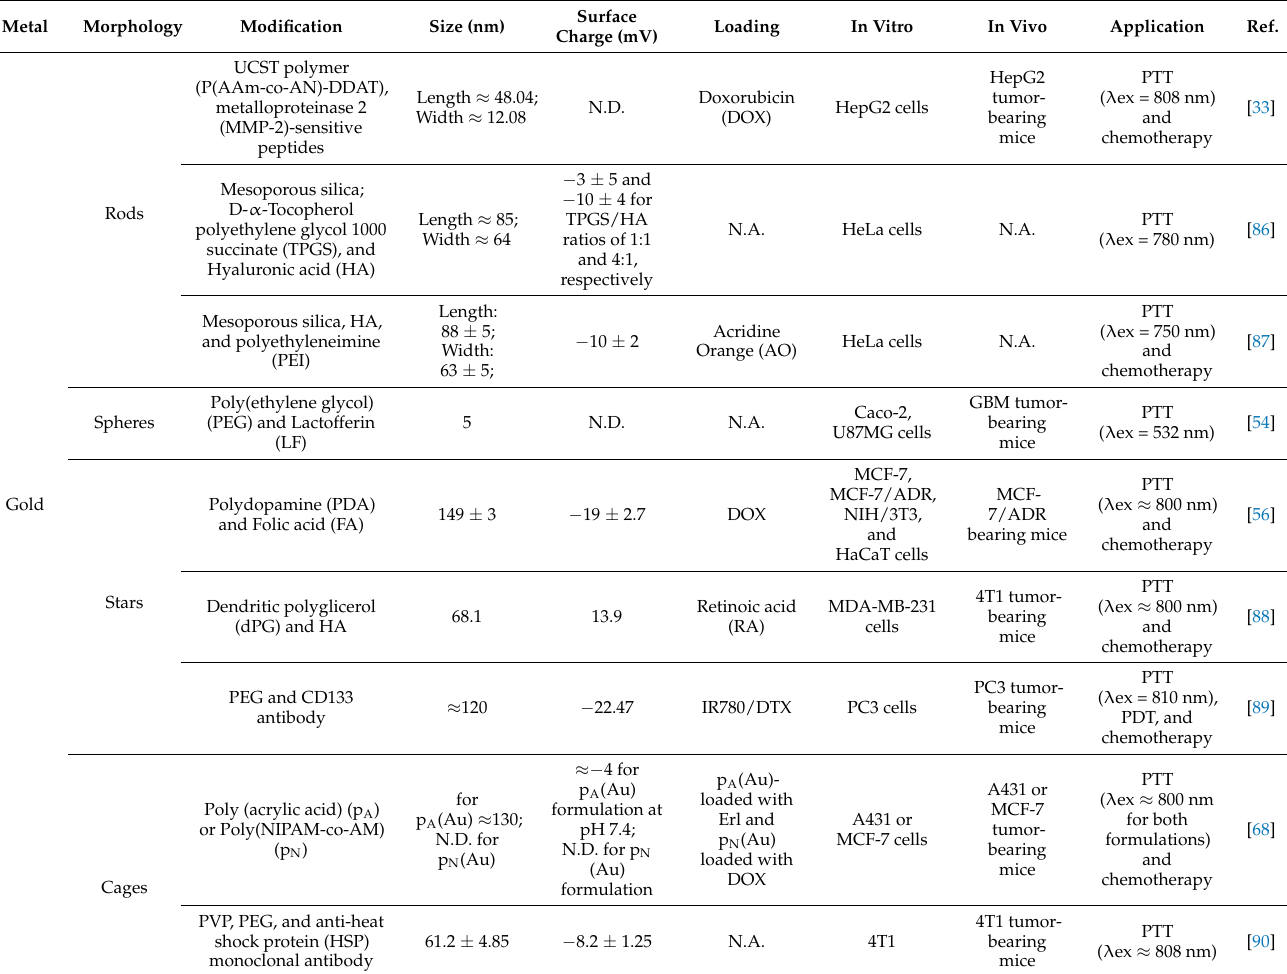
Table 1. Gold-based metallic-polymer nanoconjugates/nanohybrids, their physicochemical proper- ties, and therapeutic applications (N.D.—non disclosed, N.A.—not